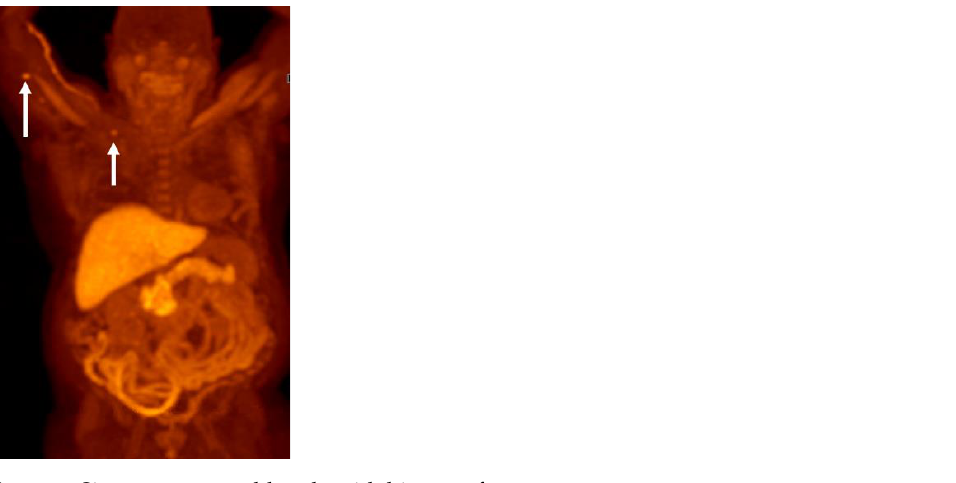
Figure 8. Sixty-year-year-old male with history of prostate cancer, status post-prostatectomy, now presenting with rising PSA levels. Axumin MIP image shows increased Axumin uptake in the right upper extremity and axilla (arrows) concerning for nodal metastasis.